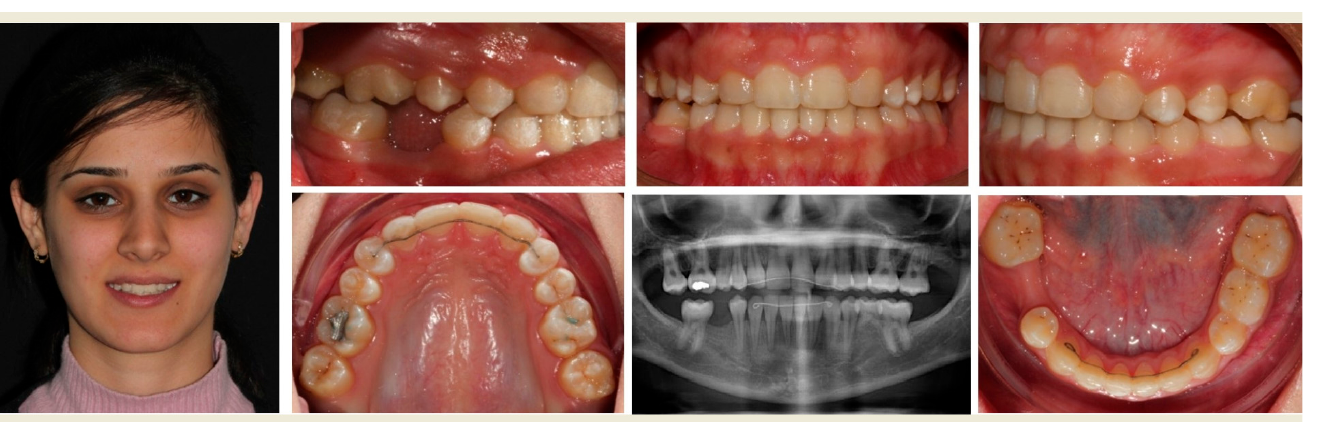
Figure 1. Pre-treatment photographs of a 14-year-old female with congenitally missing maxillary lateral incisors, mandibular second premolars, second permanent molars, and retained mandibular left second deciduous molar.